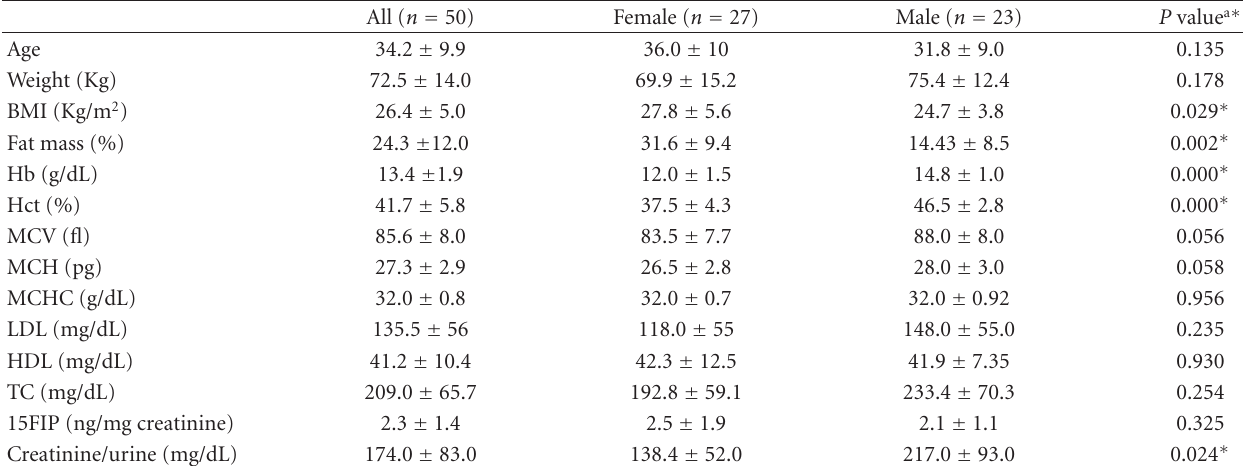
Table 1: Baseline characteristics of the study subjects.